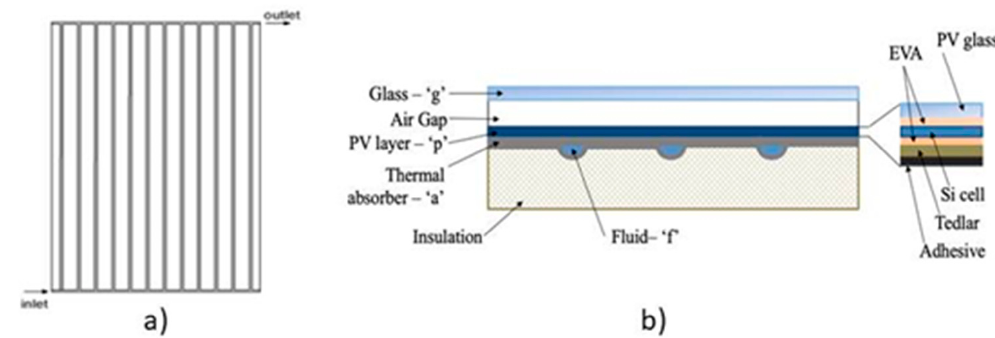
thermo-physical, optical properties and the parameters of the PVT collector used in the simulation and analyses.